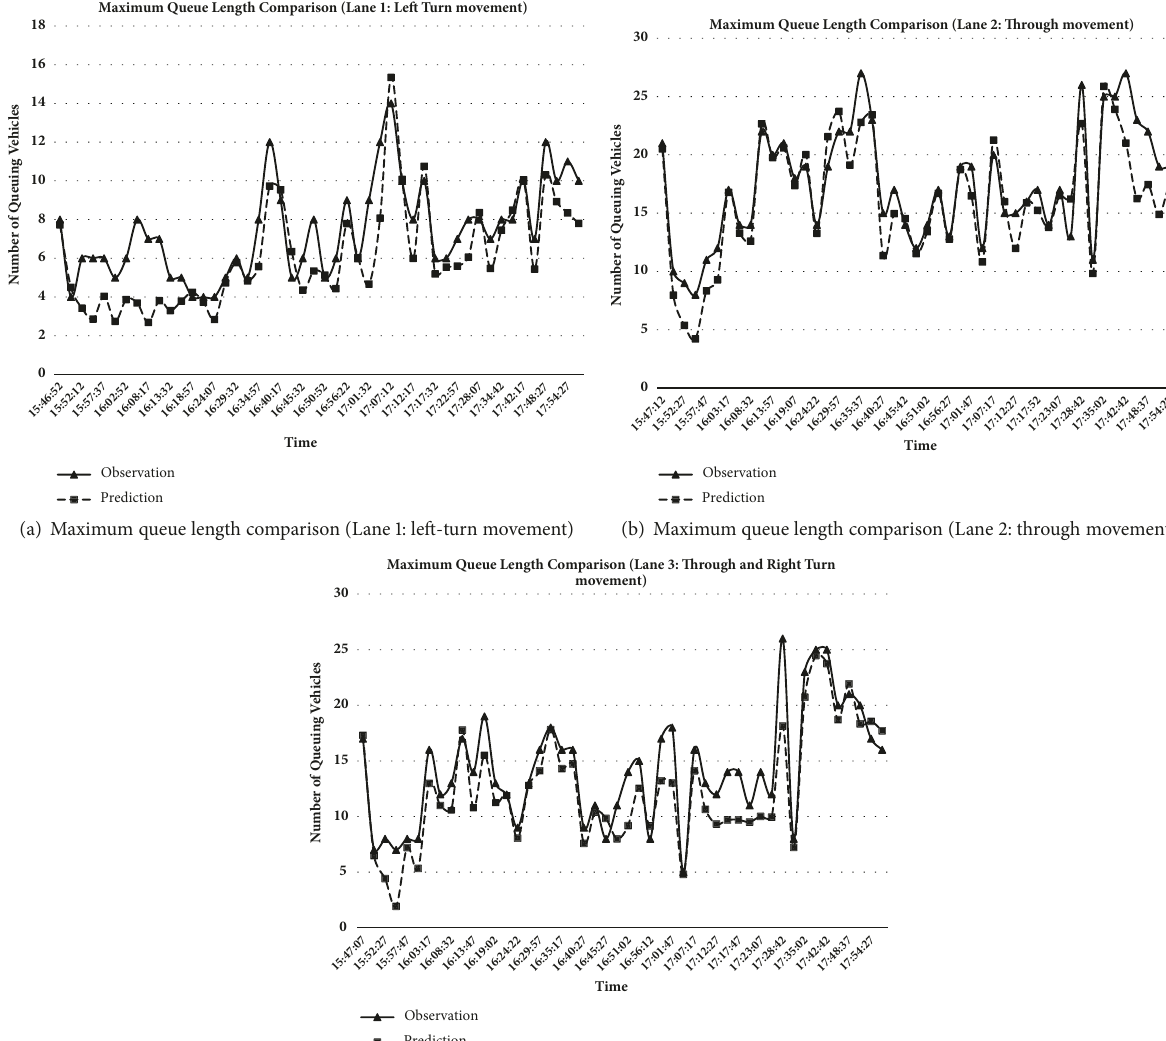
(c) Maximum queue length comparison (Lane 3: through and right-turn movement) Figure 8: Maximum queue length comparison.